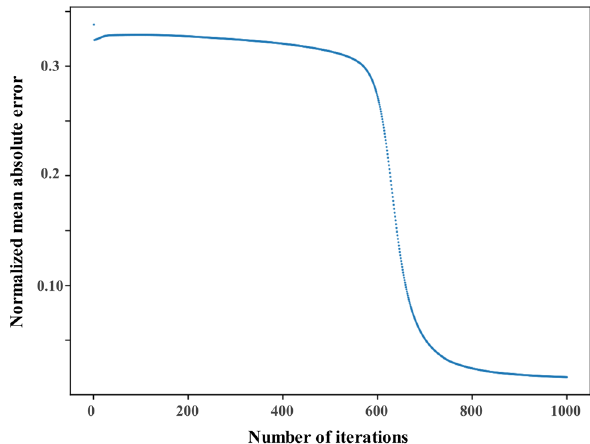
Figure 10: Result of average absolute error.